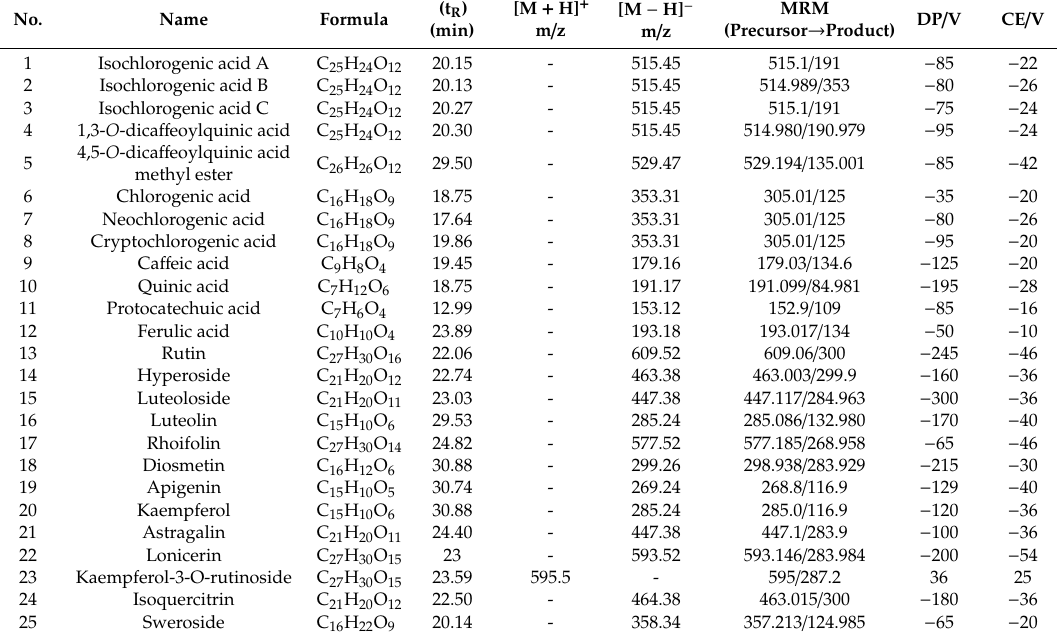
Table 1. Retention times and related mass spectrometry (MS) data of the target